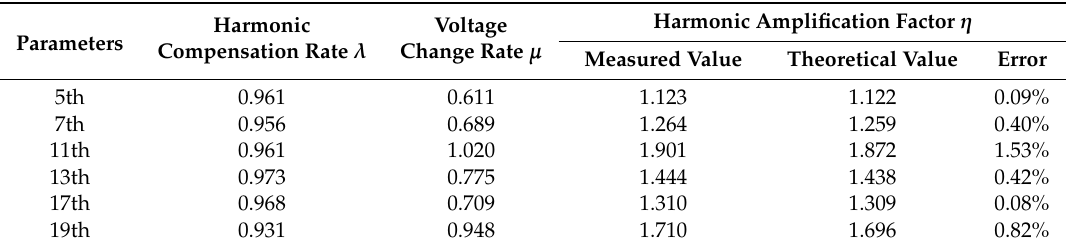
Table 2. Simulation results.